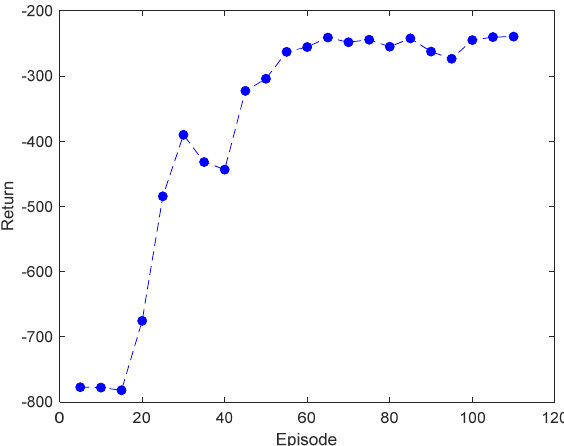
Figure 7. Learning curve of DDPG algorithm on vibration-control task.